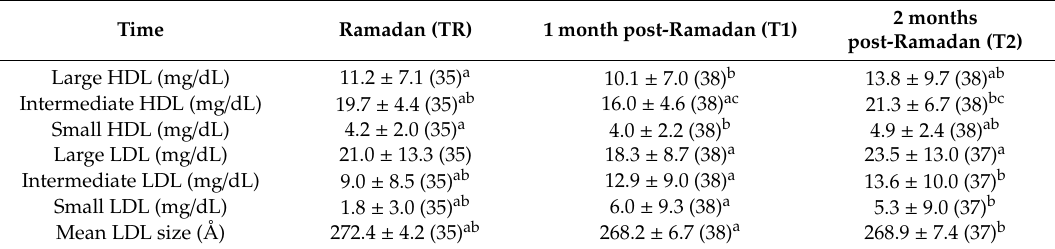
Table 4. Cholesterol distribution in lipoprotein subfractions.